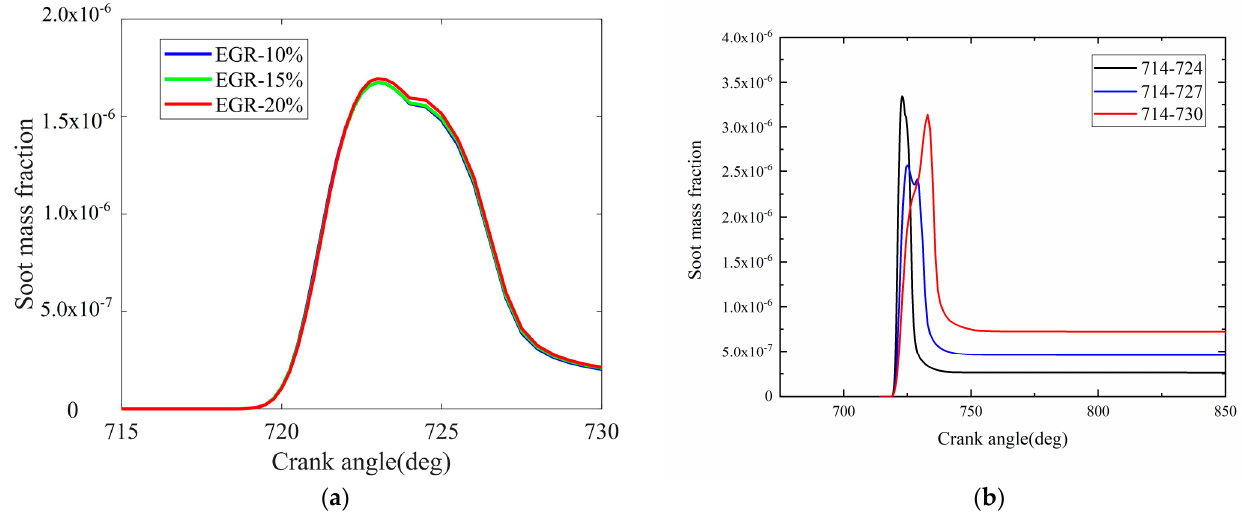
Figure 15. Soot emission for different EGR rates and injection durations: ( a ) different EGR rates; ( b ) different injection durations.